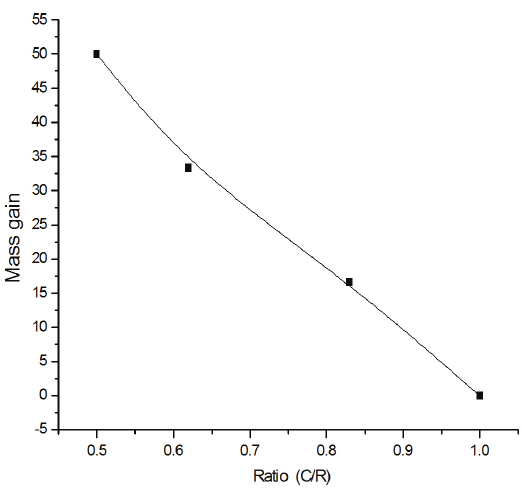
Figure 6. Distribution of the adhesive shear stresses τ